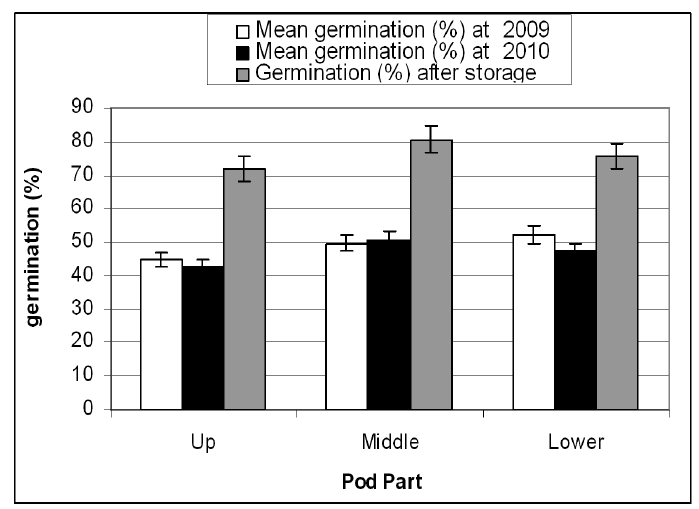
Fig. 4. Effects of different pod parts and seed storage on germination in 2009 and 2010